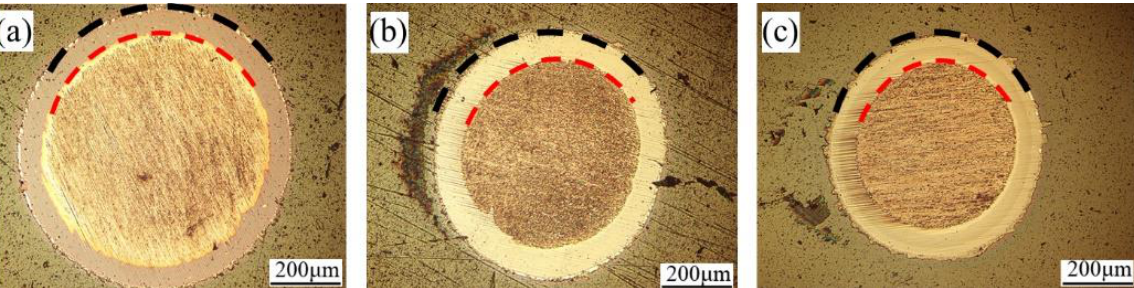
Figure 7. Microscopic photos of film thickness of Si-DLC with different transition layers: ( a ) AlTiSiN/Si-DLC; ( b ) AlCrN/Si- DLC; ( c )